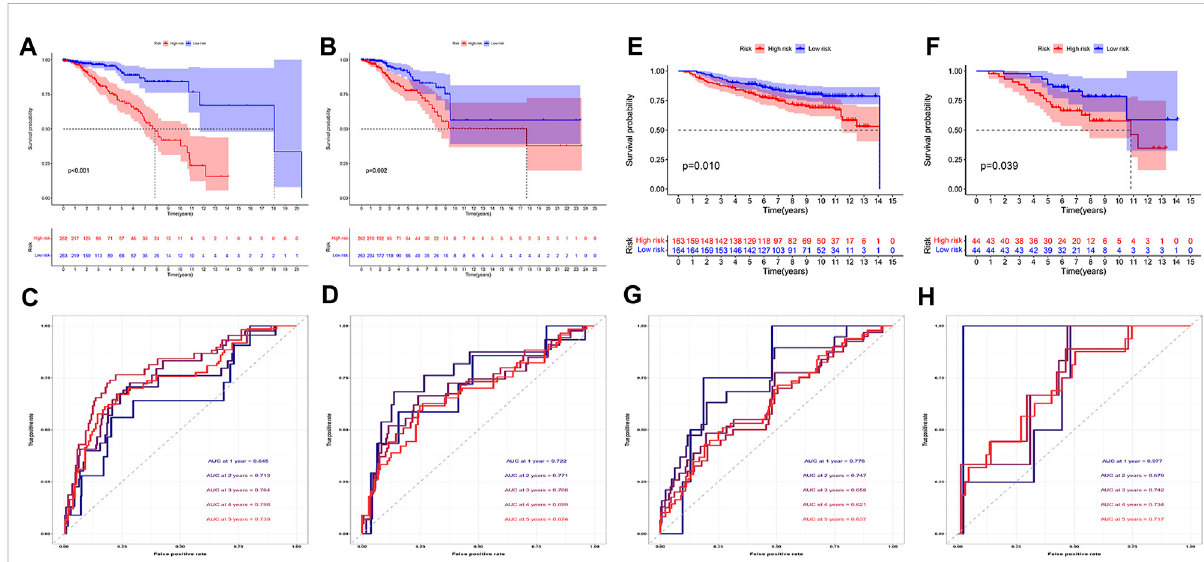
FIGURE 4 Evaluation of prognostic model. (A,B) In both training (A) and test cohorts (B, n = 525), the high-risk patients had a worse prognosis ( p < 0.05). (C,D) We found that the AUC in both training (C) and test (D) cohorts were greater than or close to 0.7. (E,F) In both GSE20685 [ (E) , n = 382] and GSE20711[ (F) , n =89]cohorts,patientswithhigh-riskscoreshadasigni fi cantlyworseprognosisthanthosewithlow-riskscores( p < 0.05). (G,H) The AUC of the GSE20685 (G) and GSE20711 (H) cohorts was basically between 0.6 and